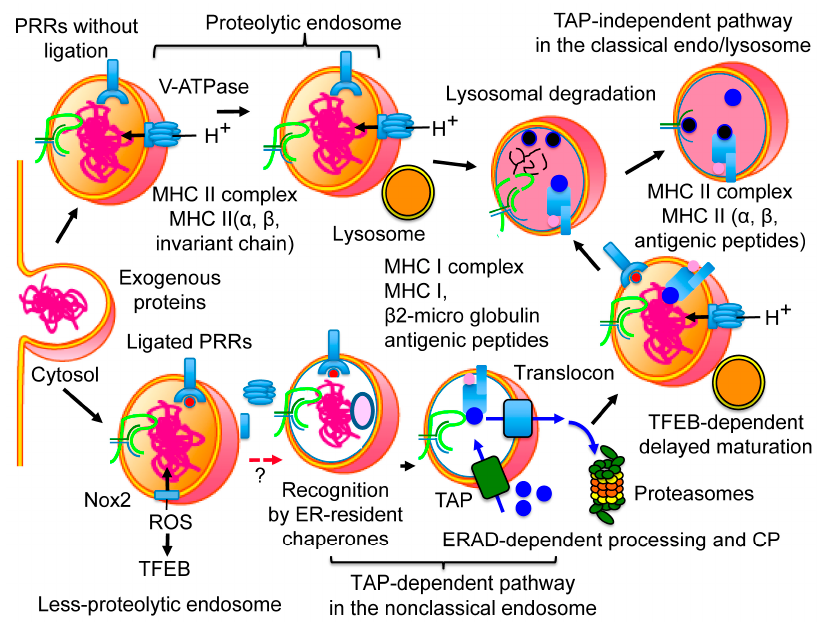
Figure 1. Maturation of endosomes and cross-presentation (CP). After internalization, exogenous proteins are transported into the endosome. Endocytic compartments without danger signals are acidified, fused with the lysosome, and designated as the proteolytic endosome. Since extracellular proteins without danger signals are self-proteins, those proteins are quickly degraded by the lysosomal proteases, which results in lower CP e ffi ciency. When danger signals are detected by pattern recognition receptors (PRRs) (TLR2, TLR4, Nod1, Nod2), the acidification of endocytic compartments is delayed by the incomplete assembly of V-ATPase and the activation of Nox2, and resulted in the less-proteolytic endosome. The activated Nox2 produces reactive oxygen species (ROS), and ROS promote nonspecific disulfide bond formation to unfold extracellular proteins. As extracellular proteins with danger signals are non-self-proteins, these proteins are recognized by the endoplasmic reticulum (ER)-resident molecular chaperones in the non-classical endosome. Recognition by the ER-resident molecular chaperones accelerates ER-associated degradation (ERAD)-dependent processing of exogenous proteins and results in higher CP e ffi ciency. ROS also activate TFEB, and activated TFEB promotes the maturation of the less-proteolytic endosome with a time di ff erence. The activated TFEB also induces maturation of DCs by initiating the transcription of costimulatory molecules, several cytokines, and chemokines, including IL-1 β , IL-6, TNF- α , and CCL5. In contrast to the major histocompatibility complex (MHC) I, MHC II presents antigenic peptides processed by lysosomal protease. MHC II associates with antigenic peptides under acidic conditions in the lysosome.